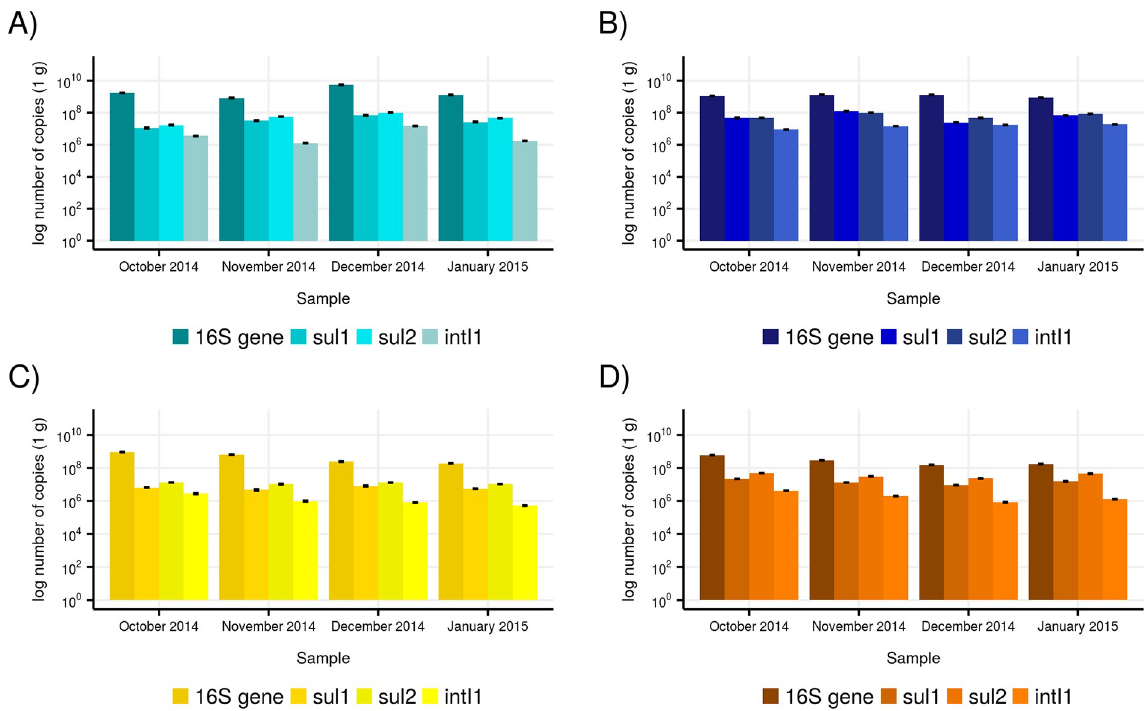
Fig 2. Mean absolute abundances of 16S rRNA, class 1 integrase ( intI1 ) and sulfonamide resistance ( sul1 and sul2 ) genes in Awba (A), Apete (B), Abule-Agege (C) and Ogbe Creek (D) for October 2014, November 2014, December 2014 and January 2015.